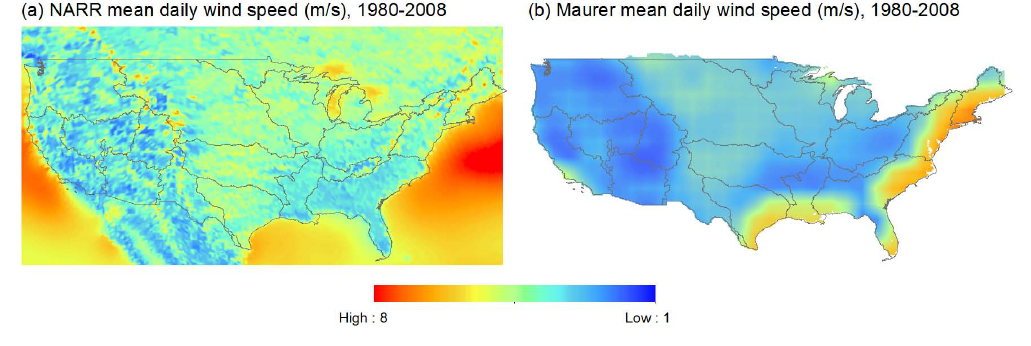
Fig. 5. Maps of mean daily wind speed.